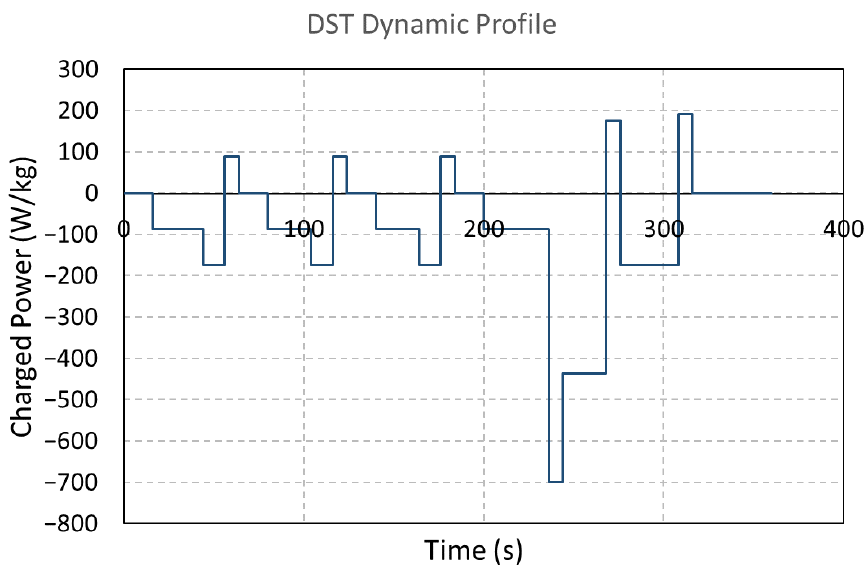
Batteries 2022 , 8 , 285 Figure 2. USABC Dynamic Stress Test (DST) power profile, escalated to a 700 W/kg maximum power.